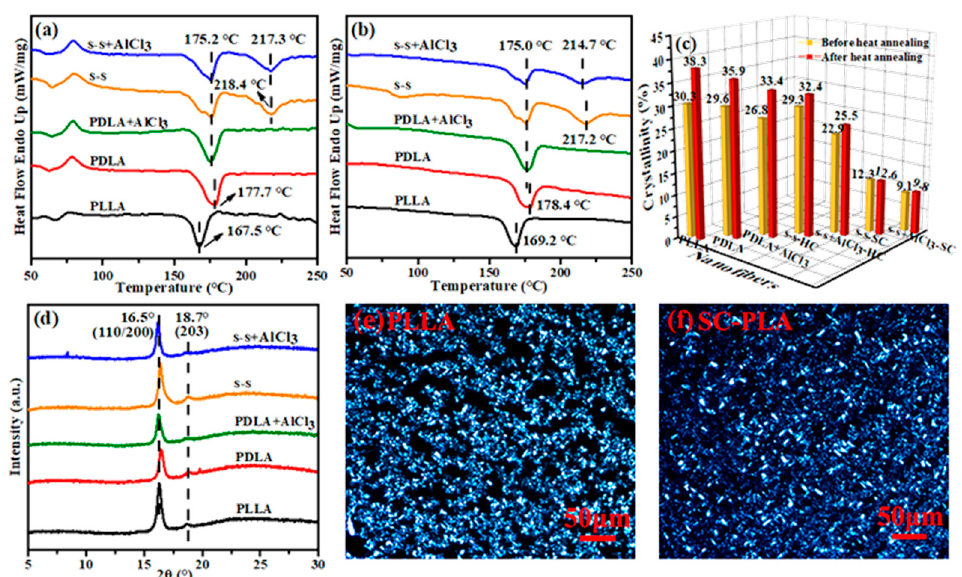
Figure 4. DSC curves of PLLA, PDLA, PDLA+AlCl 3 , s-s, s-s+AlCl 3 fiber membrane samples ( a ) before and ( b ) after heat annealing at 110 ◦ C; ( c ) the crystallinity data calculated under different conditions; ( d ) XRD curves of five fiber membranes; POM diagrams of ( e ) PLLA and ( f ) SC-PLA.